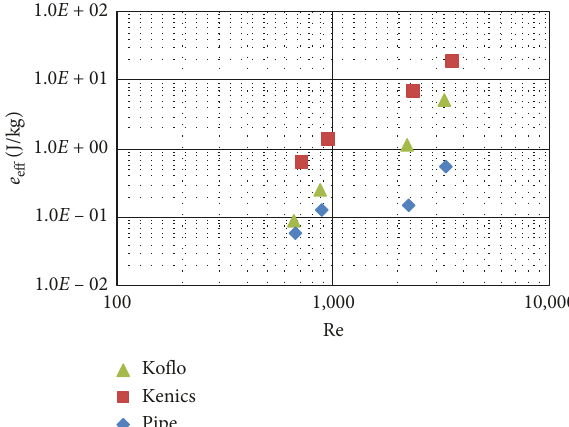
Figure 27: The total effective energy